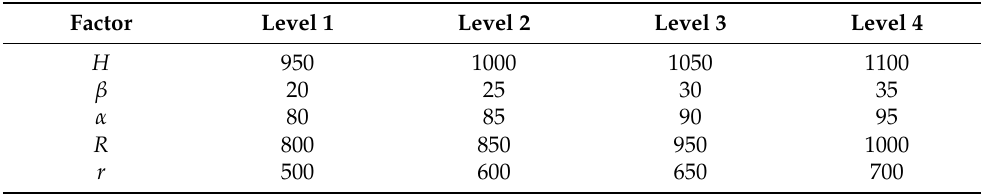
Table 4. Influencing factors and levels.